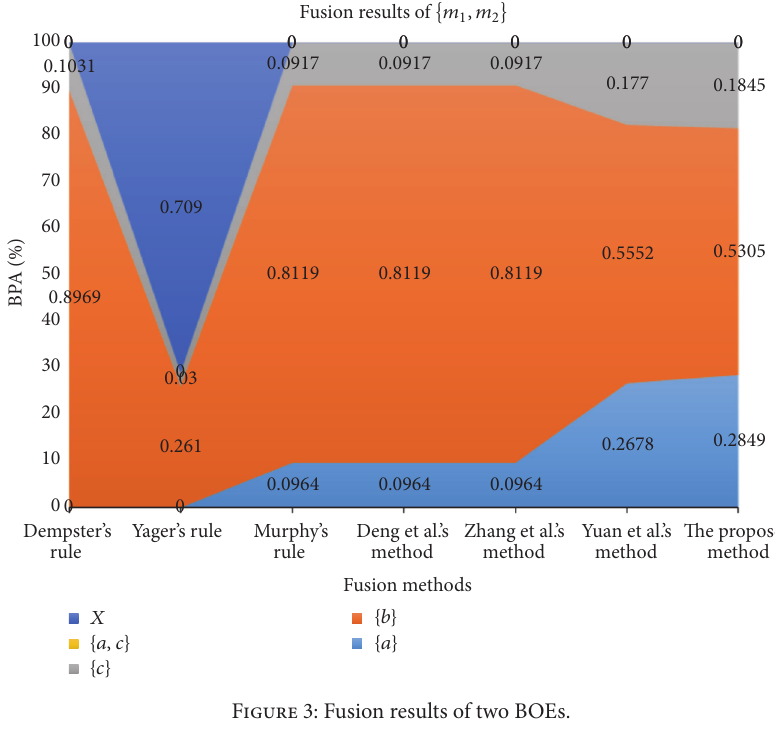
Figure 3: Fusion results of two BOEs.